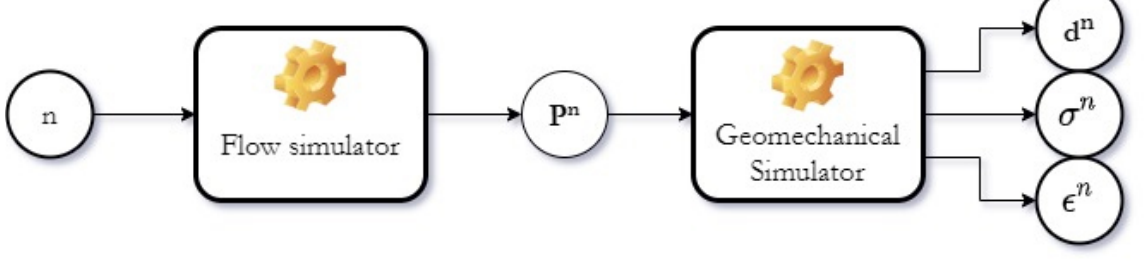
Figure 2. One-way coupling